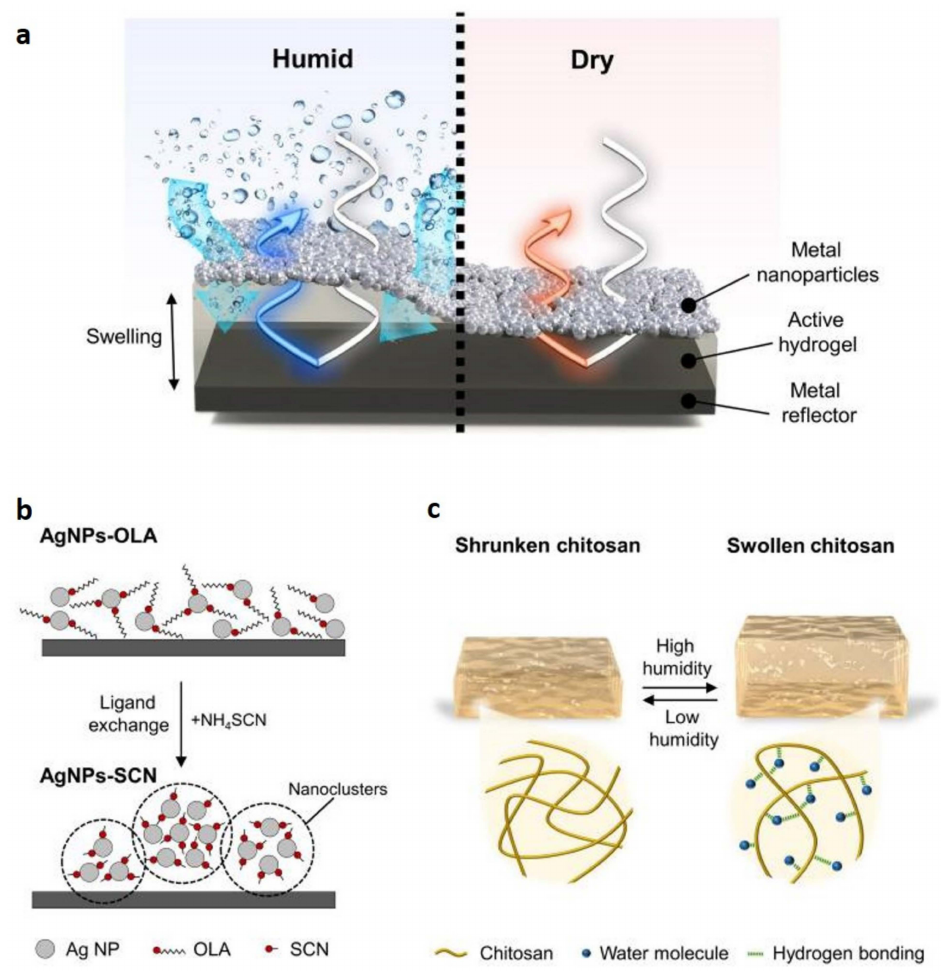
Figure 12. Graphical illustration of MNHM etalon and its ingredients. ( a ) Schematics of MNHM etalon under the humid and dry state of the surrounding. ( b ) Ligand exchange of AgNPs-OLA transformed to AgNPs-SCN. The aggregated nanoclusters form membrane pores that aid the pene- tration of gas into the hydrogel layer. Gray circle, Ag NP; dot with zigzag tail, OLA ligand; dot with straight tail, SCN ligand. ( c ) Swelling/contraction of chitosan hydrogel under the change of humidity condition. Yellow line, chitosan network; blue dot, water molecule; green dashed line, hydrogen bonding between the chitosan network and water molecules